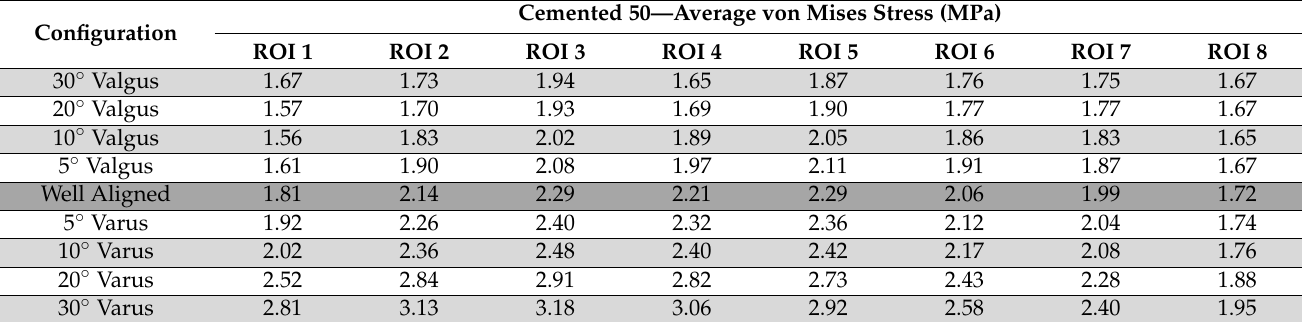
Table 8. Average von Mises stresses in the different ROIs for the 50 mm cemented stem.